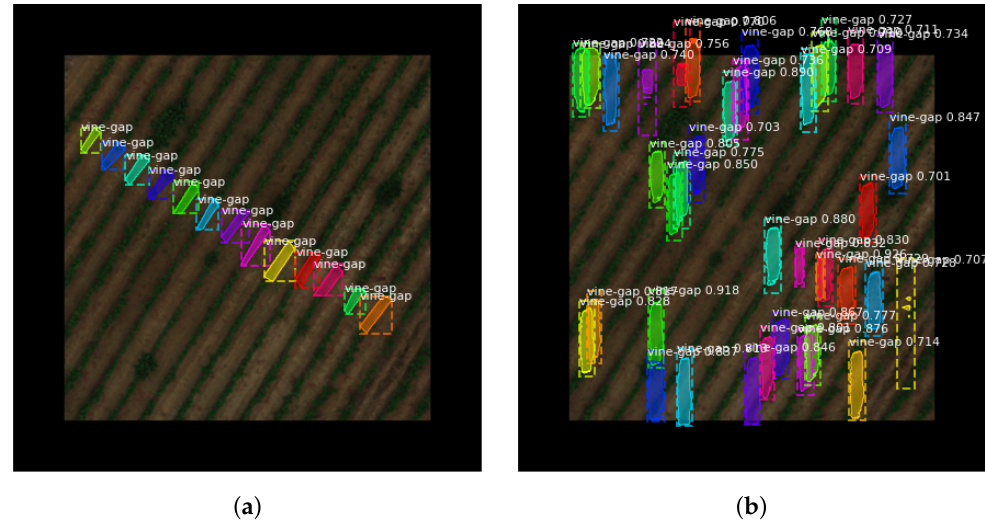
Figure 8. Examples of Mask-RCNN, after training ‘head’ layers for 30 epochs, failing to detect diagonal objects. Dataset: RGB; Weights: Tiny-YOLOv2; ( a ): Original; ( b ):